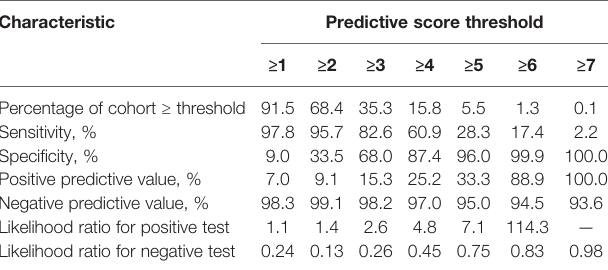
TABLE 4 | Performance characteristics of risk-predictive model at different predictive score thresholds. Characteristic Predictive score